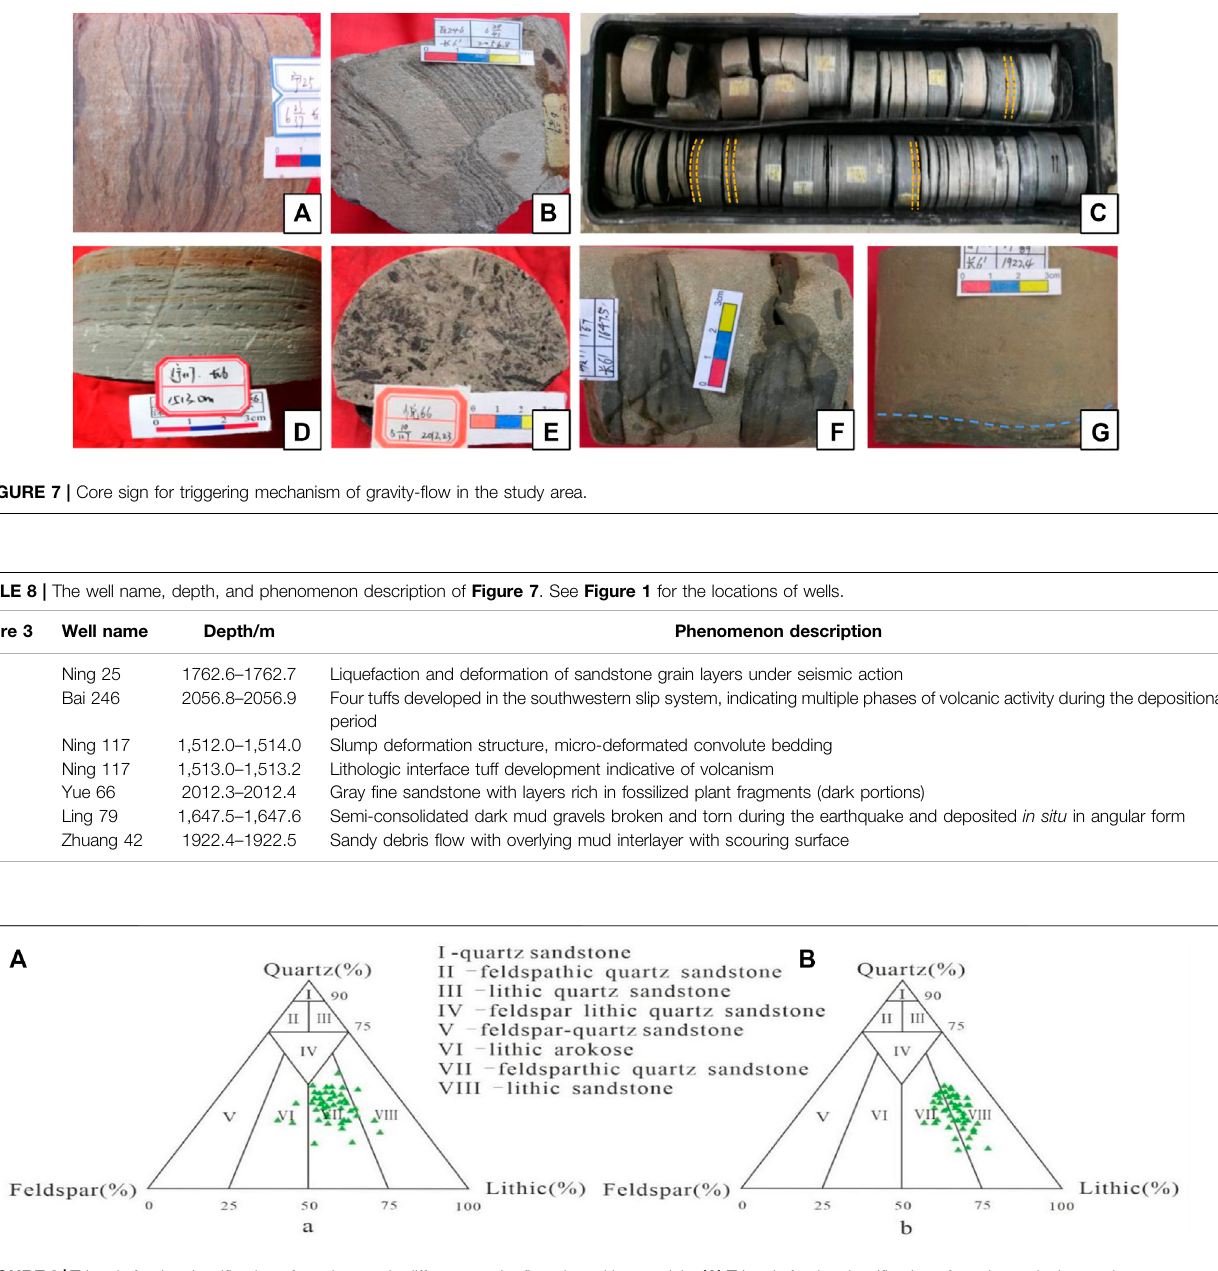
FIGURE 8 | Triangle for the classi fi cation of sandstones in different gravity- fl ow deposition models. (A) Triangle for the classi fi cation of sandstone in the southwest of the study area; (B) triangle for the classi fi cation of sandstone in northeast of the study area.